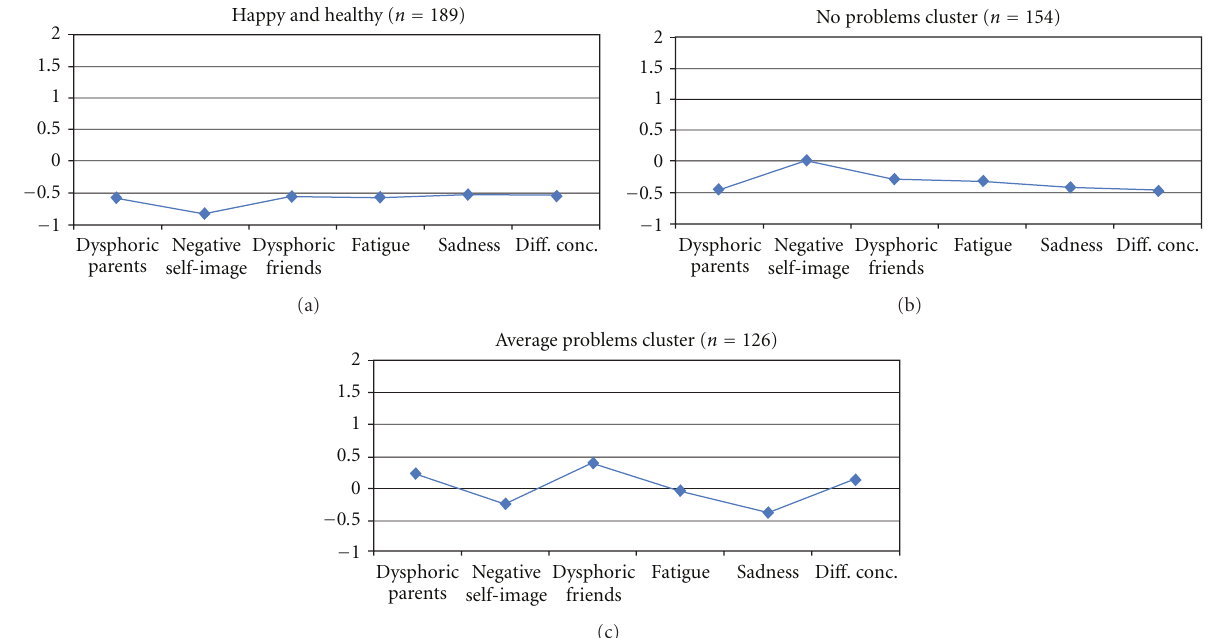
Figure 4: Healthy clusters. Profiles in terms of z -scores (where z = 0 corresponds to the whole sample’s mean on each subscale). symptoms scale is not su ffi ciently sensitive to capture the role of depressive symptoms for the development of self-harm, as it contains only one depression-related